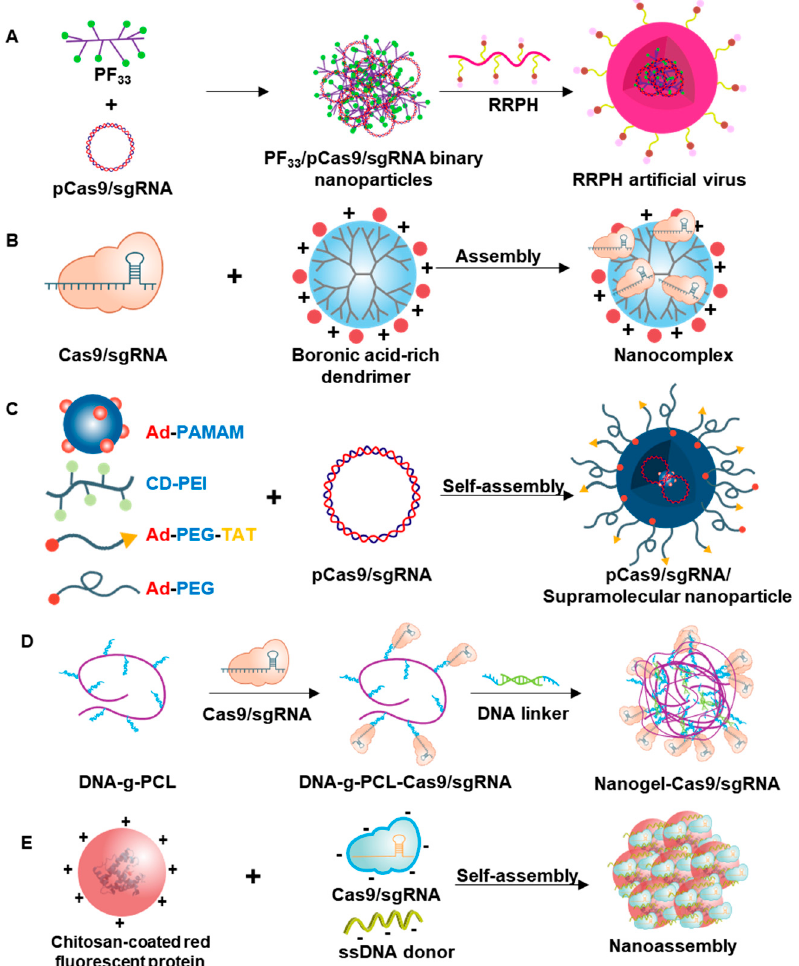
Figure 3. Polymeric systems for CRISPR/Cas9 and sgRNA delivery. ( A ) Fluorinated polyethyleneimine-based artificial virus for pCas9/sgRNA delivery. Adapted from [36], ACS, 2016. ( B ) Boronic acid-rich dendrimer for Cas9/sgRNA delivery. Adapted from [63], AAAS, 2019. ( C ) Supramolecular nanoparticle for pCas9/sgRNA delivery. Adapted from [38], WILEY-VCH, 2020. ( D ) Nucleic acid nanogel for Cas9/sgRNA delivery. Adapted from [64], RSC, 2019 ( E ) Chitosan-coated red fluorescent protein for Cas9/sgRNA and DNA donor delivery. Adapted from [65], RSC, 2019.